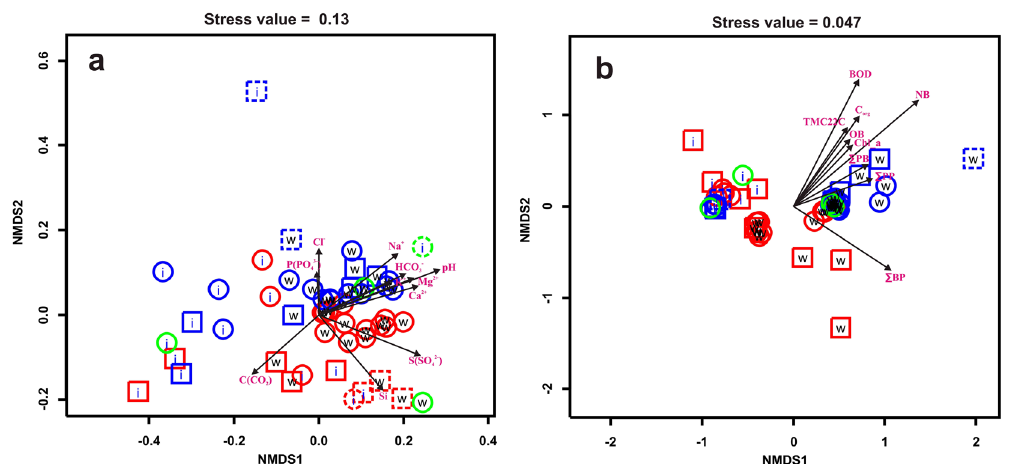
Figure 2. Scatter plots of sampling sites in two-dimensional NMDS space. ( a ) parameters describing biological processes are treated as explained variables, hydrochemical parameters are treated as explanatory ones, ( b ) hydrochemical parameters are explained, biological parameters are explanatory. Red — eastern coast, blue — western coast; green circles represent pelagic samples; circles — samples taken from the lake near river mouths, squares — river mouths; dashed blue squares are samples taken near the mouth of Bolshaya Cheremshanka river; dashed red pointers are samples taken near Bolshaya Osinovka and Malaya Osinovka rivers; w — water samples, i — ice samples. Plots show only the vectors of gradient for explanatory variables significantly affecting the datasets of explained variables (Tables 1 and